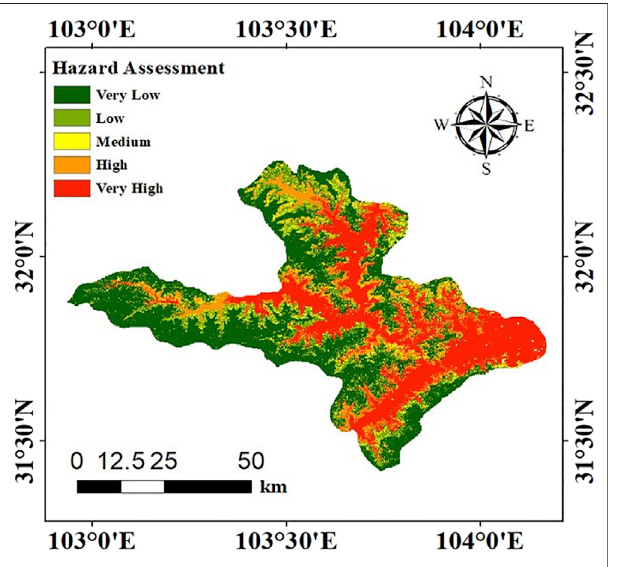
FIGURE 6 | The hazard map of geological disaster.